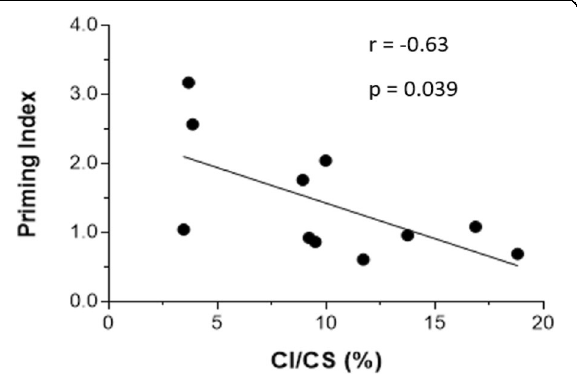
Fig. 1 (abstract 001118). See text for